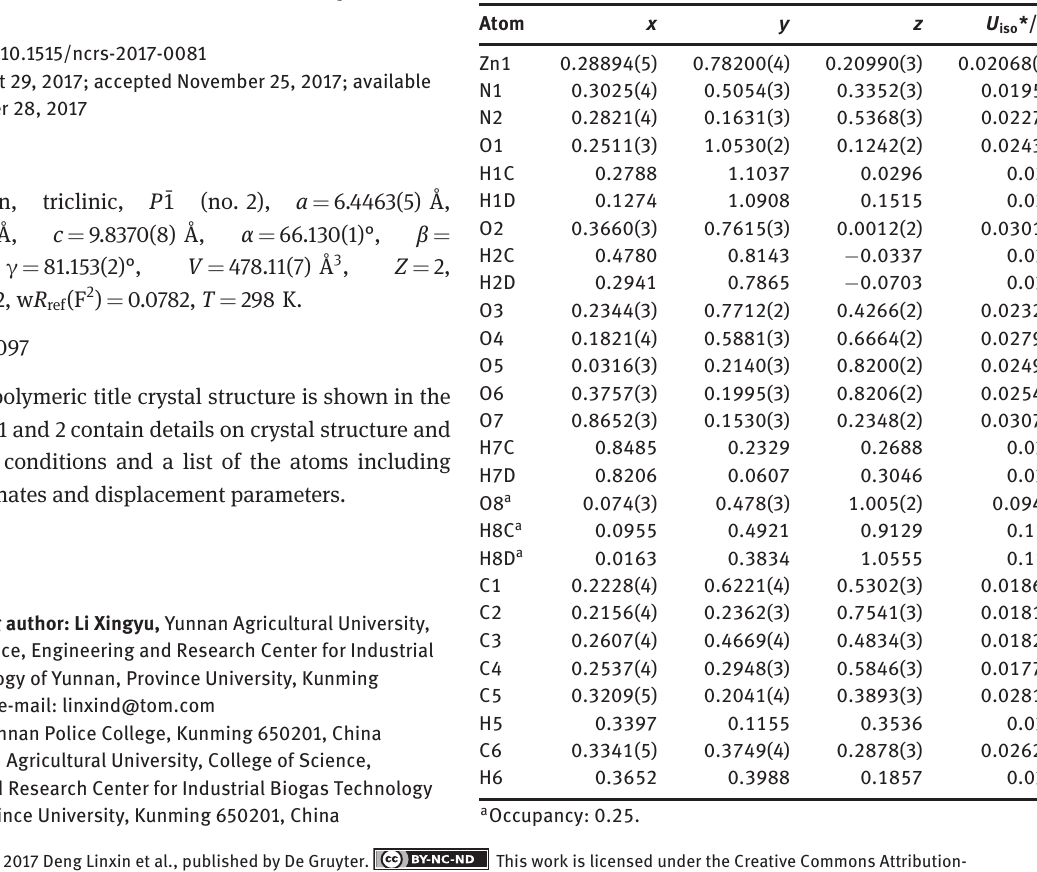
Table 2: Fractional atomic coordinates and isotropic or equivalent isotropic displacement parameters (Å 2